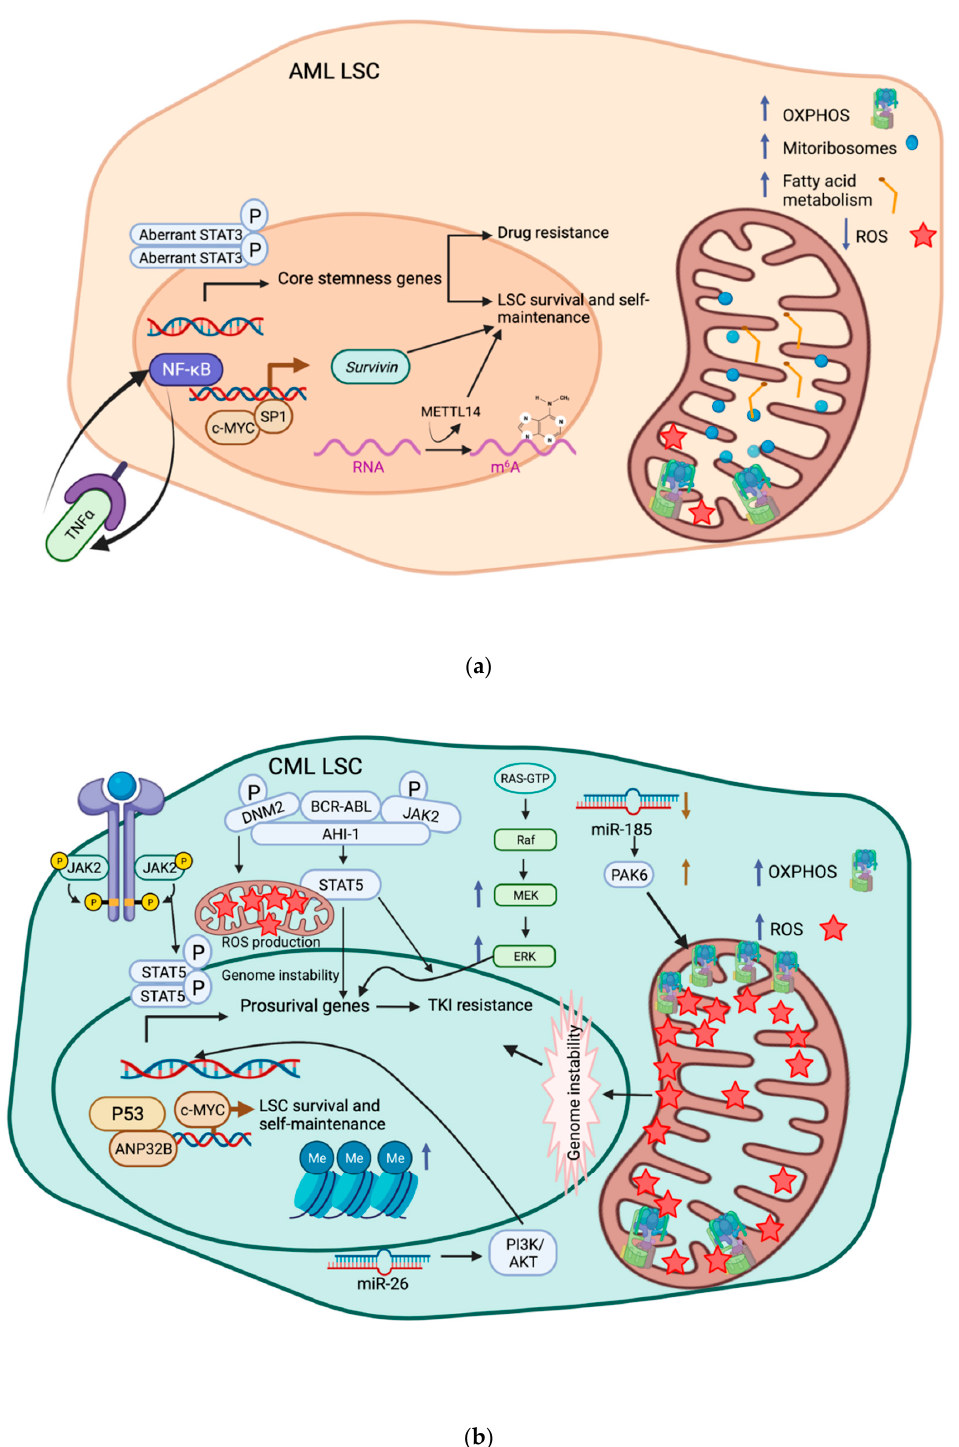
Figure 2. Multi-omics circuitry of AML and CML LSC-mediated drug resistance. ( a ) Notable transcriptomic features of AML LSCs include dysregulated transcription factors, such as STAT3, the aberrant activation of which is associated with the transcription of core stemness genes; constitutive NF κ B activation, which can be mediated by a self-sustaining, autocrine positive feedback loop with tumor necrosis factor- α (TNF- α ); and aberrant c-Myc activity, which, along with sp1, enhances transcription of survivin , concertedly driving LSC survival, self-maintenance, and drug resistance. Epigenetically, m 6 A RNA modification by METTL14 is essential for LSC self-renewal and